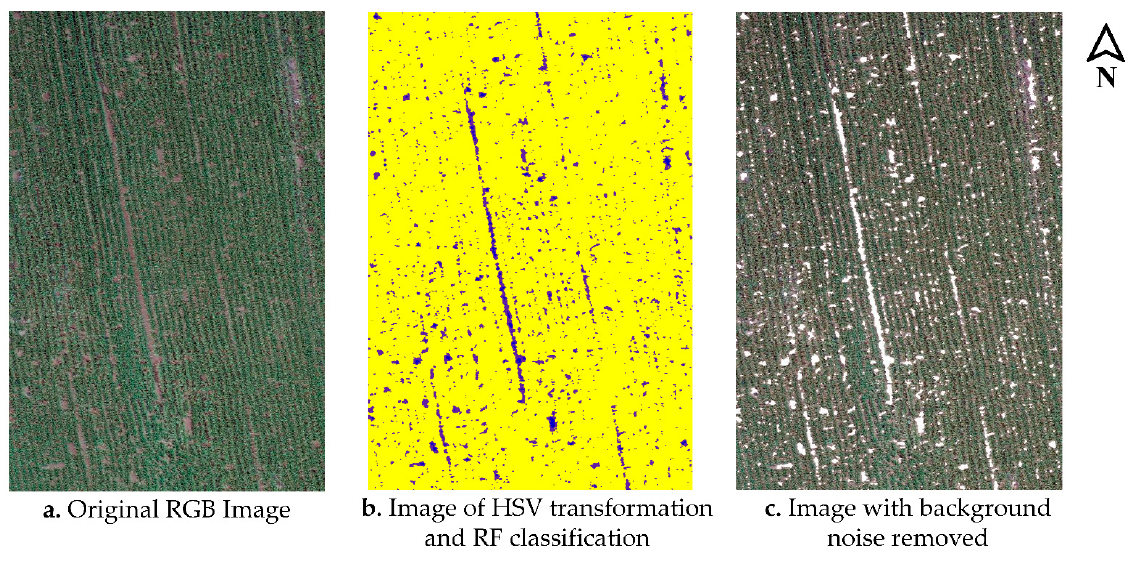
Figure 6. Process of background noise removal.